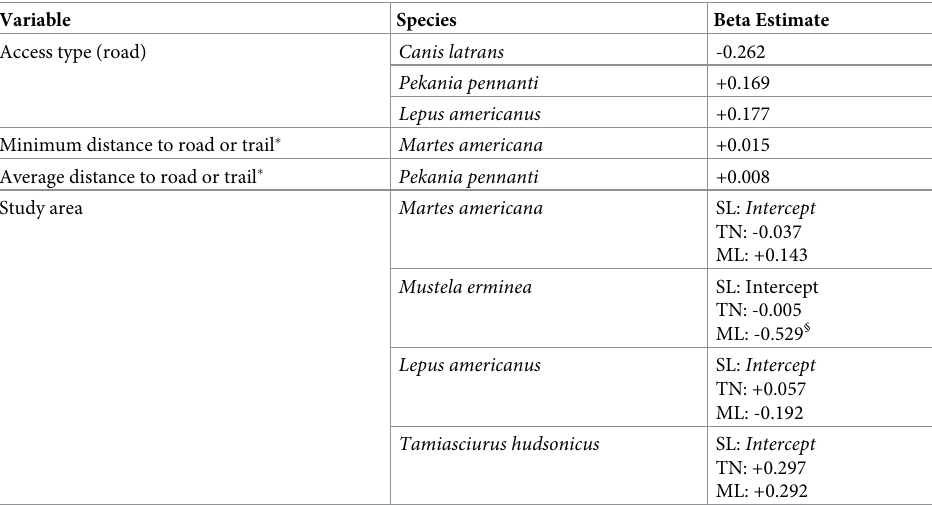
Table 4. Influence of camera site features on detection probabilities for six mammal species in Maine,